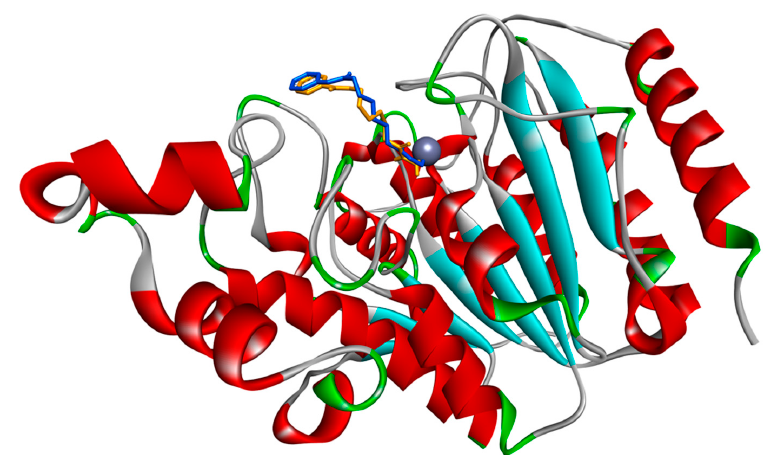
Figure 2. Interaction of the inhibitor vorinostat with HDAC2 from a crystallographic structure and re-docking simulations. The complex HDAC2-vorinostat obtained by redocking simulation has been superimposed to the crystallographic complex. Vorinostat from redocking (orange molecule in stick representation) occupies the same site as in the crystallographic complex (blue molecule). HDAC2 backbone is represented as a ribbon, with red helices and cyan strands. Grey sphere indicates the Zinc atom in the site. Image is generated by DiscoveryStudio4.5.